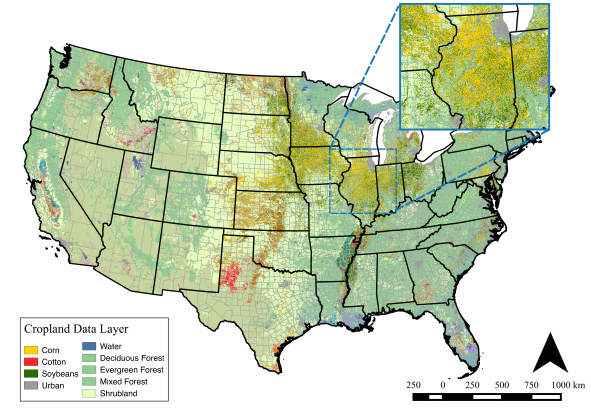
Figure 3: Cropland Data Layer